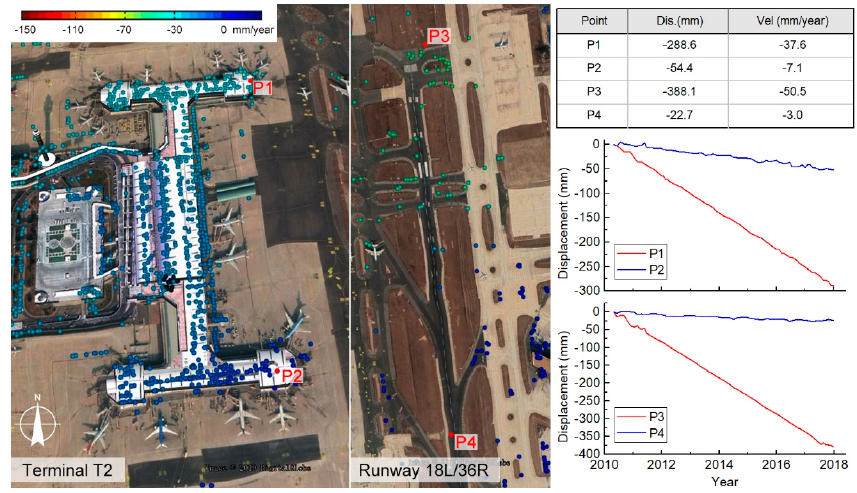
Figure 10. The locations of the selected points P1, P2, P3, and P4 and comparison of the time series displacement and subsidence velocity of each point on the right.